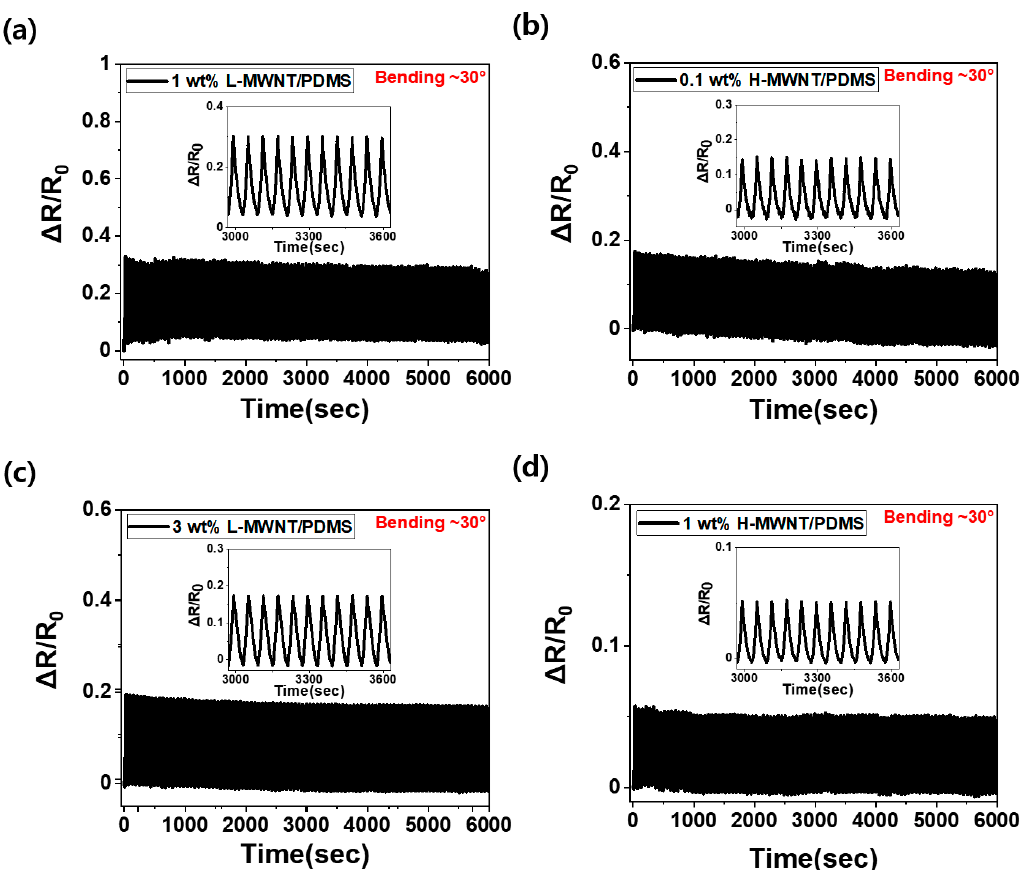
Figure 6. Δ R/R 0 following 100 cycles of continuous bending and releasing deformations up to a bending angle of 30°: ( a ) 1 wt.% L-MWNT/PDMS; ( b ) 0.1 wt.% H-MWNT/PDMS; ( c ) 3 wt.% angle of 30 ◦ : ( a ) 1 wt.% L-MWNT / PDMS; ( b ) 0.1 wt.% H-MWNT / PDMS; ( c ) 3 wt.% L-MWNT / PDMS; L-MWNT/PDMS; ( d ) 1 wt.% H-MWNT/PDMS. The inset image is an enlarged image of the 50–60 ( d ) 1 wt.% H-MWNT / PDMS. The inset image is an enlarged image of the 50–60 cycles.